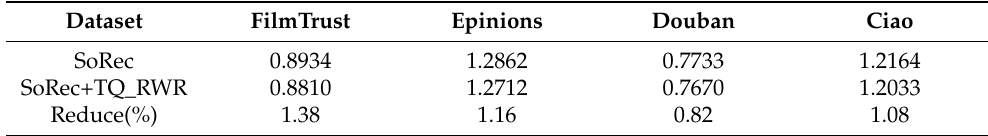
Table 3. Comparison of TQ_RWR.